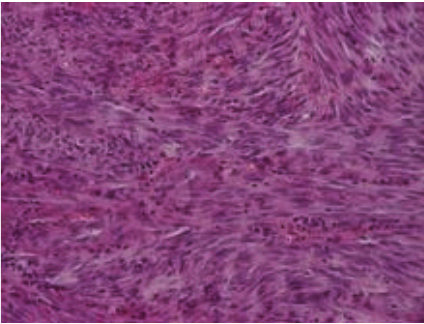
Figure1:Spindleshapedformingnumerousvascularslit-likespaces filled by red blood cells. (H+E × 250).